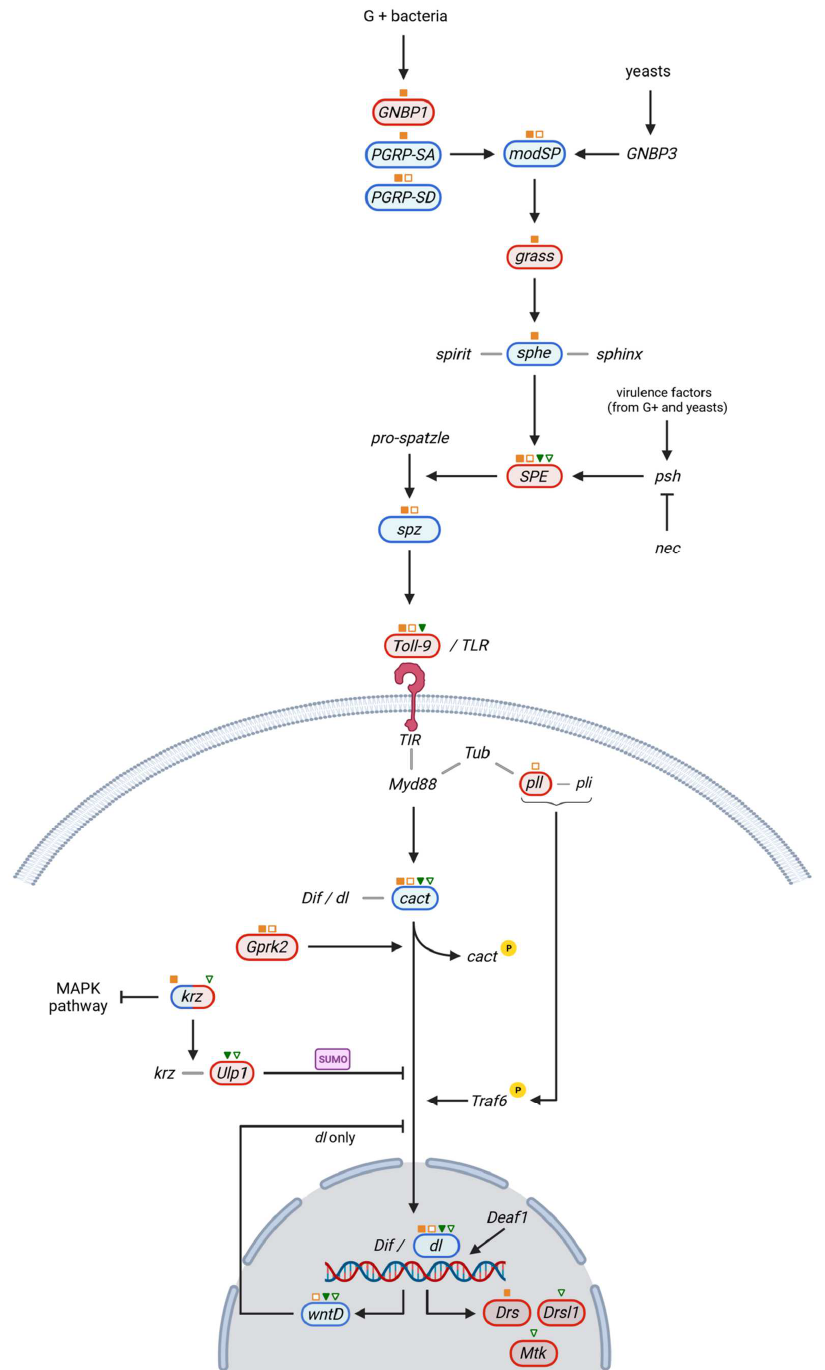
Figure 3. Biochemical model of Toll pathway activation in D. melanogaster cells as a response to microbial infection. The observed gene expression change corresponding to the experimental con- ditions and mutants is shown in blue (upregulation) or red (downregulation). With orange-filled or orange-bordered squares, we indicate that the corresponding gene significantly varies its expression in infected and, respectively, uninfected γ COP 14a / γ COP 14a males. With green-filled or green-bordered triangles we indicate that the marked gene significantly varies its expression in infected and, re- spectively, uninfected γ COP S057302 /TM6B males. Unmarked components of the pathway did not show any statistically significant expression change. Created with BioRender.com (accessed on 24 February